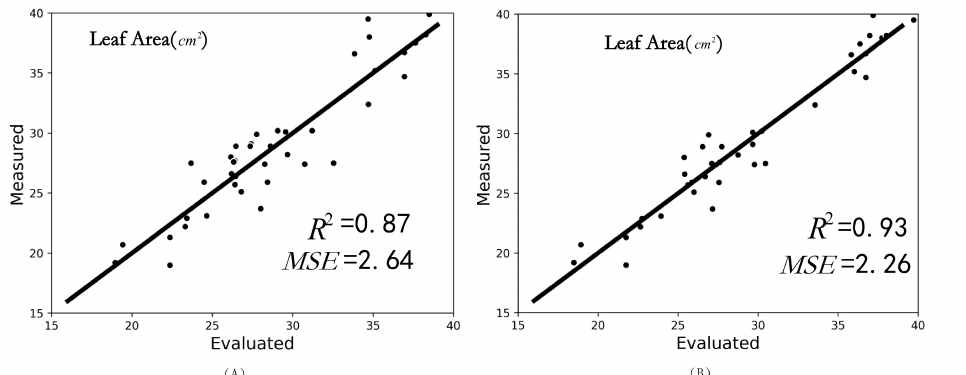
Figure 11. Correlation analysis after leaf area measurement, ( A ) indicates the correlation analysis between the leaf before restoration and the real leaf; ( B ) indicates the correlation analysis between the restored and the real